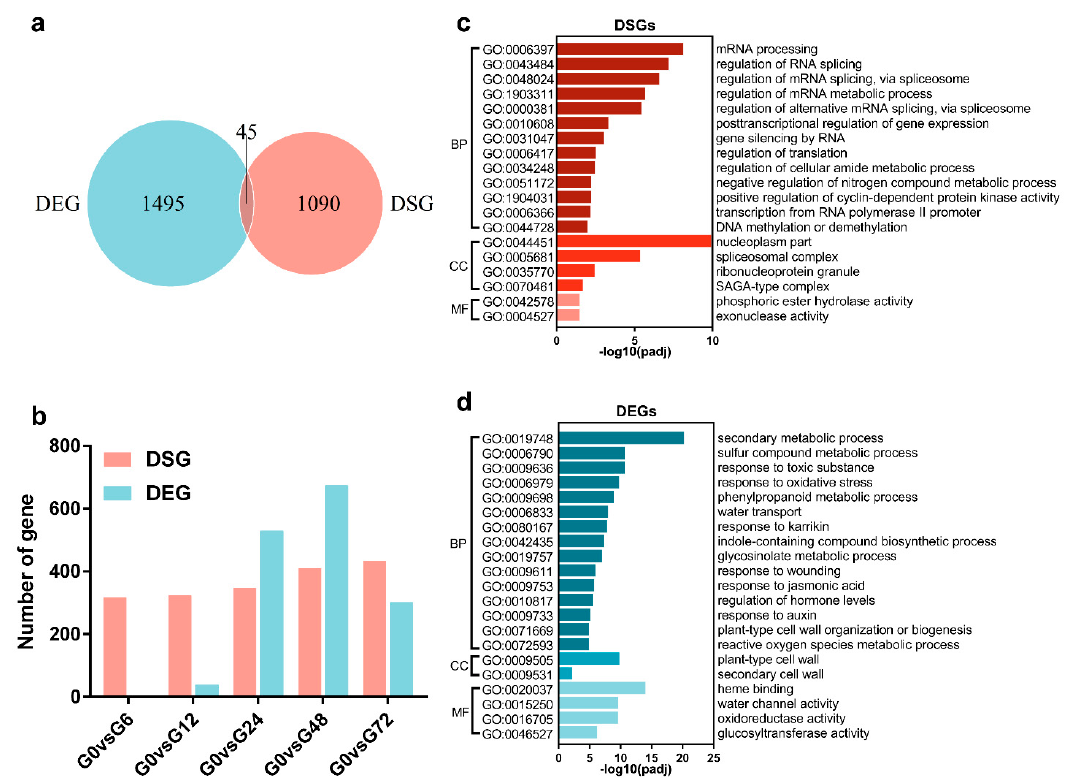
Figure 2. Comparison analysis of differentially spliced genes (DSGs) and differentially expressed genes (DEGs) in response to R. solanacearum infection. ( a ) Range comparison for DSGs and DEGs. ( b ) Number comparison for DSGs and DEGs over the time course. ( c , d ) Functional enrichment analysis of DSGs and DEGs. GO: gene ontology. BP: biological process. CC: cellular component. MF: molecular function.